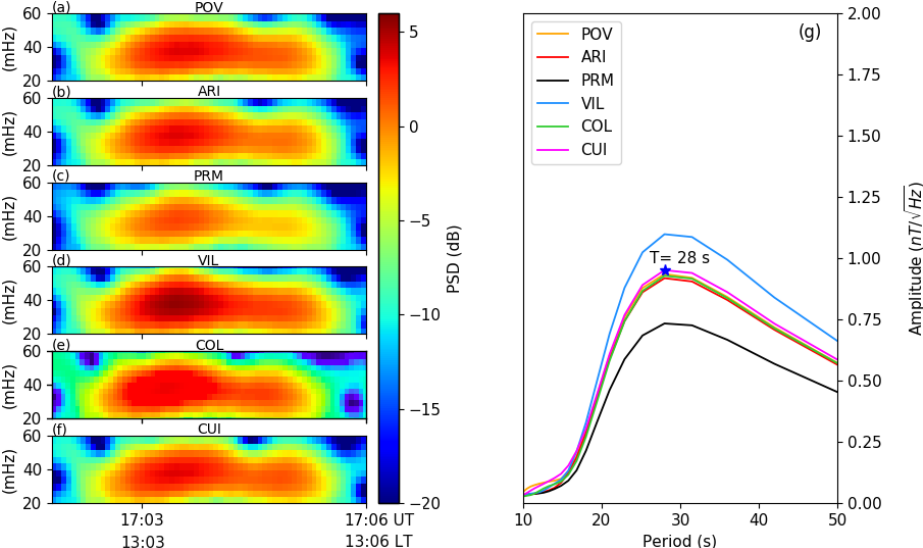
Figure 5. Power spectral analysis for the Pc3 pulsation on 15 October 1994 shown in Fig. 3. Left panels (a–f) show dynamic spectrograms of power spectral density during the event. Right panel (g) shows the average spectral amplitude at each station with identification of the period of peak amplitude in the CUI